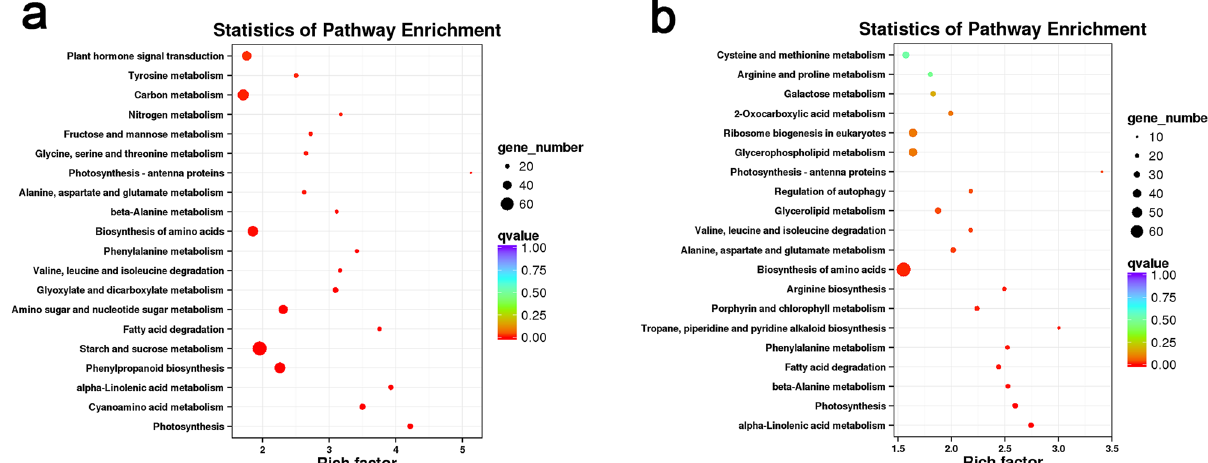
Figure 5. KEGG enrichment analysis 83–85 of the DEGs between D and DS. a , b , KEGG enrichment analysis of differentially expressed genes of D_vs_DS for 2 days and 4 days, respectively. Each circle represented a KEGG pathway, the ordinate represented the name of the pathway, and the abscissa represented the enrichment factor. The circle color represented q value, the circle size represented the number of genes enriched in the